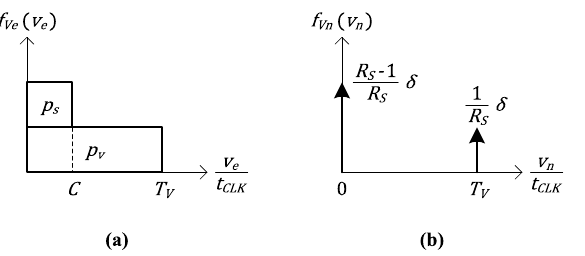
Figure 7. Sub-model distributions used in the derivation of the vacation waiting time model. ( a ) Empty queue ( b ) Non-empty